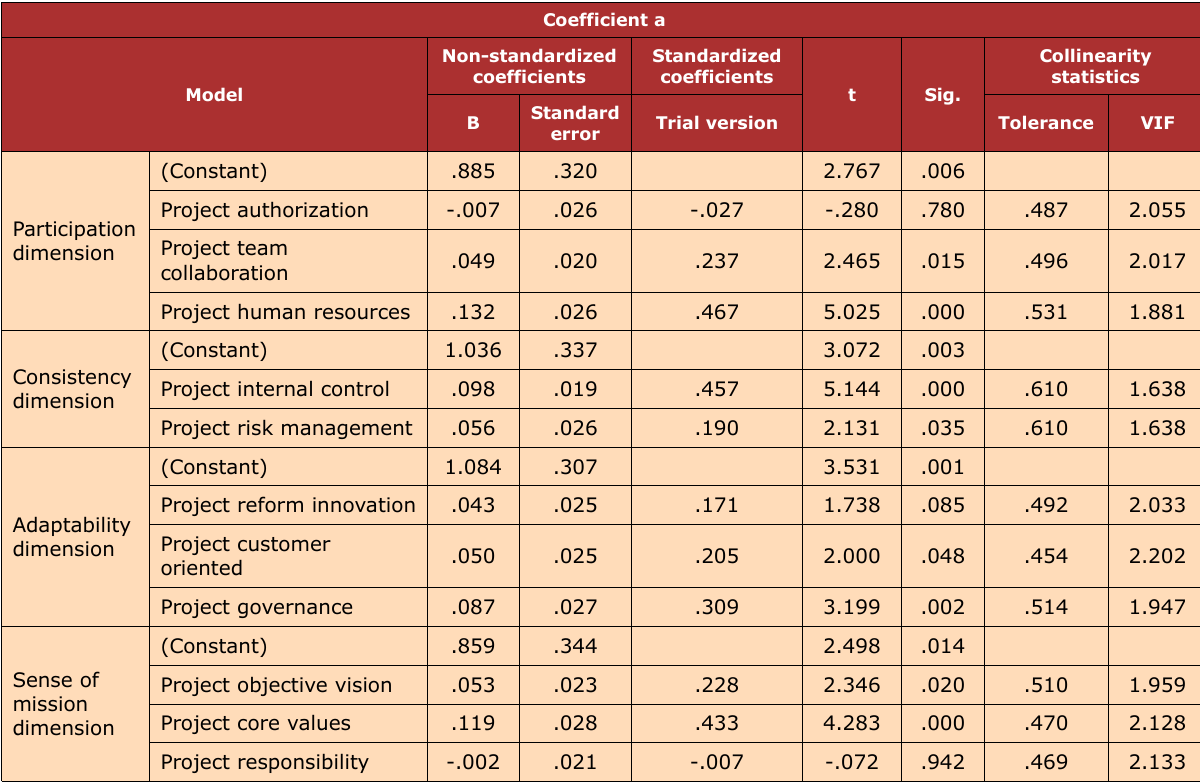
Table 10. Each Dimension and Factor Regression Model Parameter